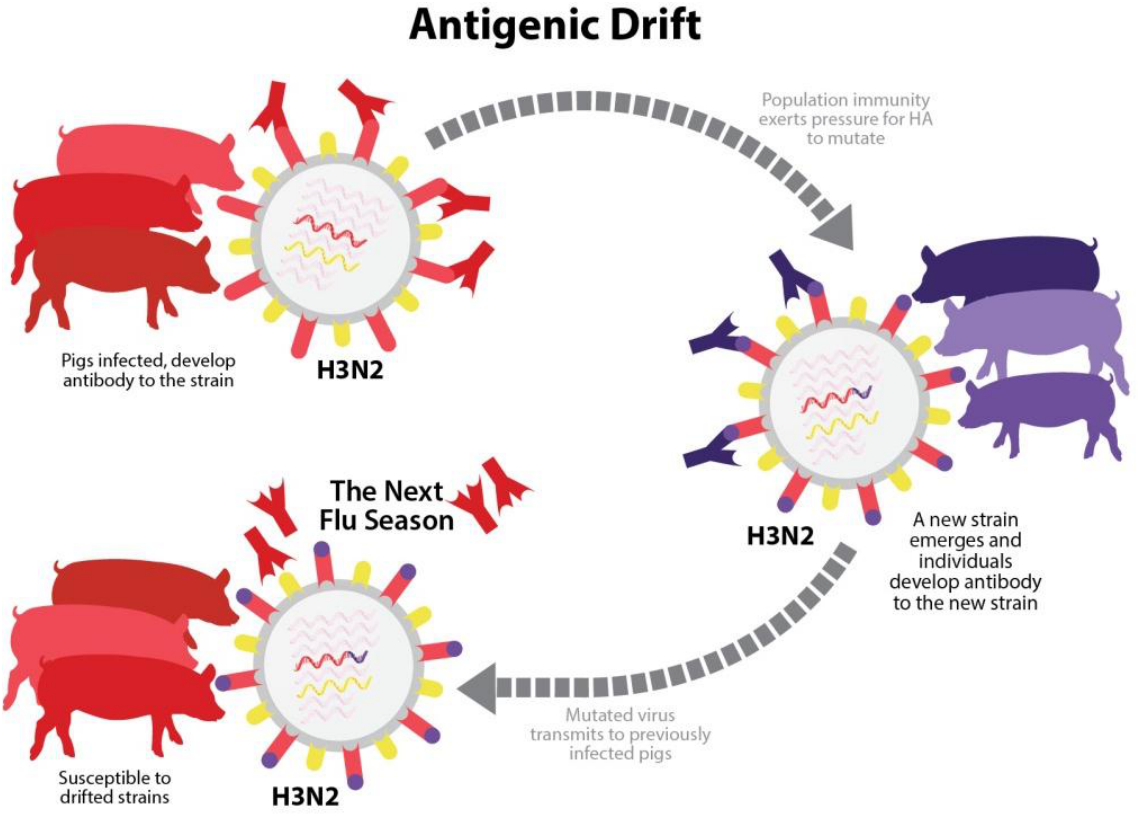
Figure 3. Antigenic drift. Over time, random mutations in HA and NA genes of an influenza A virus in swine (IAV-S) strain may cause significant changes in antigenic properties. A swine herd with population immunity to IAV-S has neutralizing antibodies specific to a strain that was previously encountered through infection or vaccination. However, if antigenic drift produces a new variant strain that pre-existing antibodies in the herd are unable to neutralize, the pigs become susceptible to